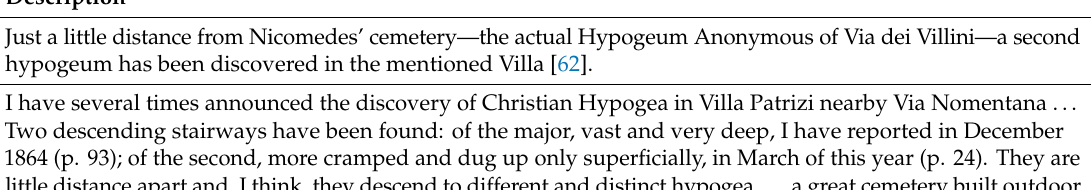
Table 1. Description of the second hypogeum discovered by De Rossi in the ancient Villa Patrizi’s area.